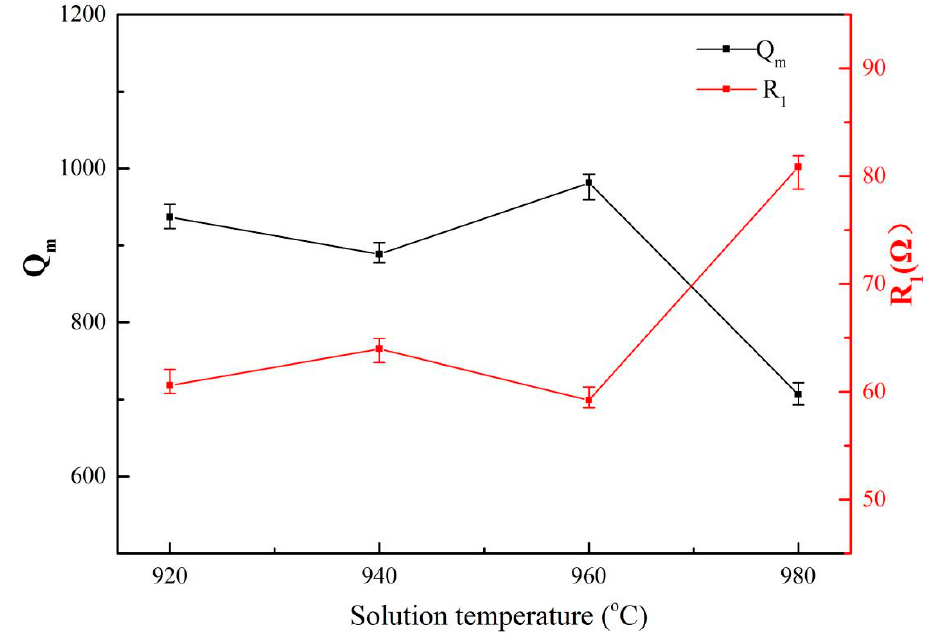
Figure 6. Ultrasonic resonant parameters of Ti6AlV alloy vibrator under different solution